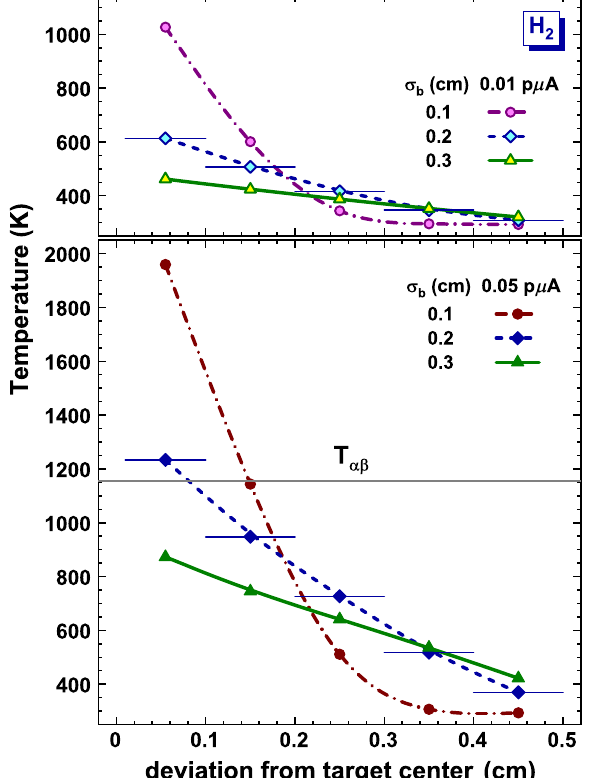
FIG. 8. Radial temperature distributions are shown (different symbols connected with respective lines) for a stationary target surrounded by rarefied H 2 under irradiation of 48 Ca with the beam-density distribution corresponding to σ b ¼ 0 . 1 – 0 . 3 cm and the intensity of 0.01 and 0 . 05 p μ A (upper and bottom panels, respectively). The radial beam-density distribution shown in Fig. 1 and the estimates of heat removal to gas due to its thermal conductivity were used in the